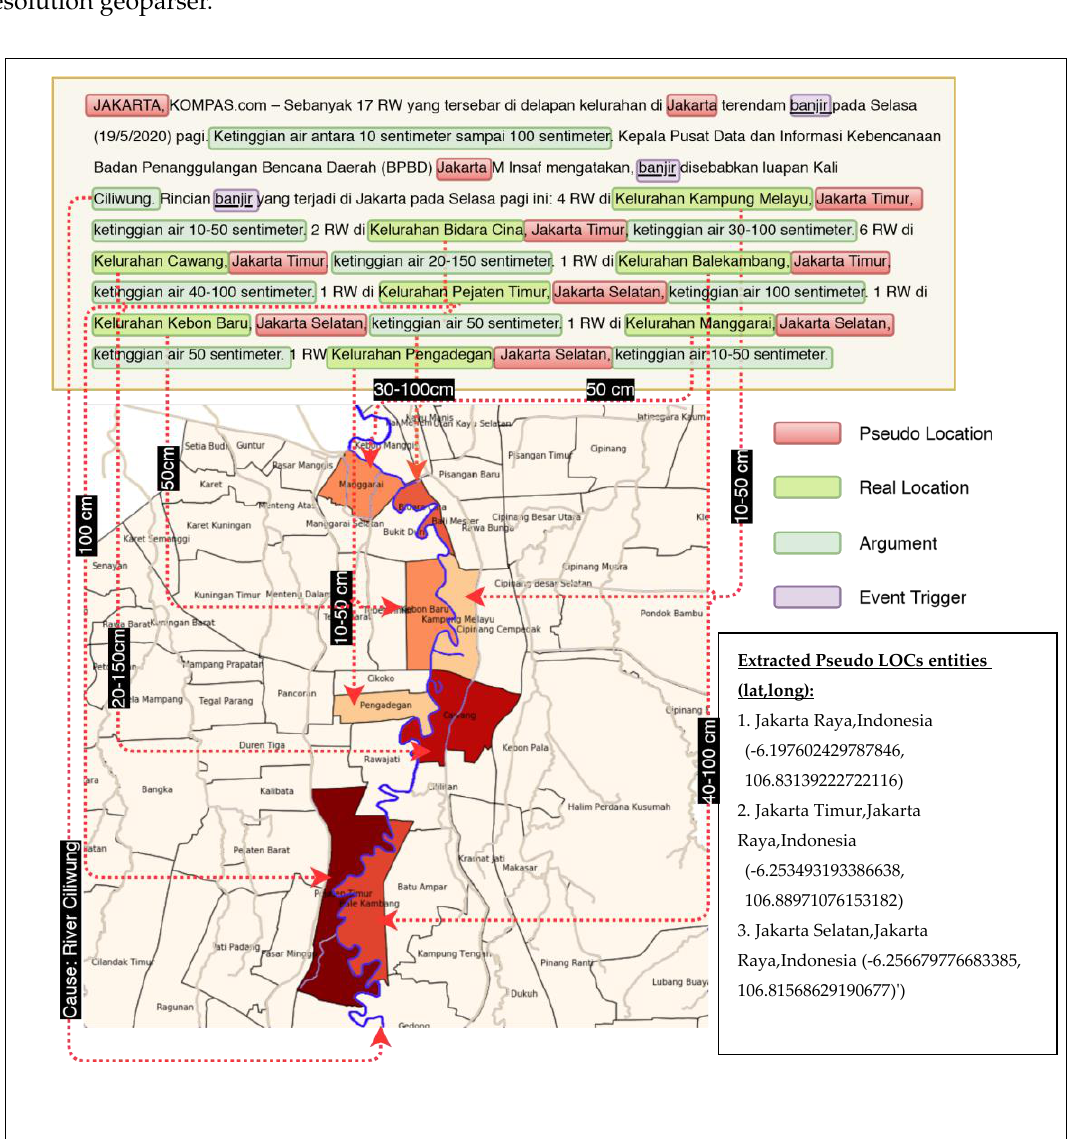
Figure 13. Visualization sample from a single article with result from our proposed Event Geoparser. The source article is displayed and tagged with colors, indicating arguments, event trigger, and pseudo-location/real-location label for every detected toponym.